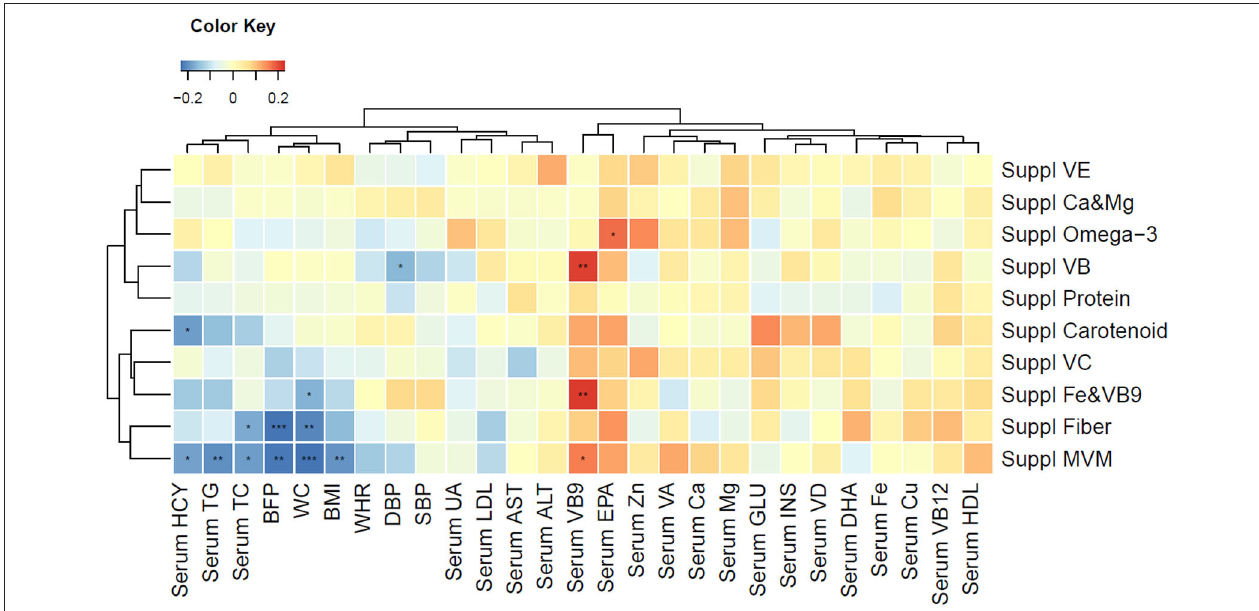
FIGURE 4 | Spearman correlation with clustered clinical outcomes (anthropometric measurements and blood biomarkers) and supplement usage. Blue color indicates strong reverse correlation; red color indicates strong positive correlation. * P < 0.05, ** P < 0.01, *** P < 0.001. ALT, alanine aminotransferase; AST, aspartate aminotransferase; BFP, body fat percentage; BMI, body mass index; Ca, calcium; Cu, copper; DBP, diastolic blood pressure; DHA, docosahexaenoic acid; EPA, eicosapentaenoic acid; Fe, iron; GLU, glucose; HCY, homocysteine; HDL, high density lipoprotein; INS, insulin; LDL, low density lipoprotein; Mg, magnesium; MVM, multiple vitamin mineral; SBP, systolic blood pressure; TC, total cholesterol; TG, triglycerides; SBP, systolic blood pressure; Suppl, supplement; UA, uric acid; VA, vitamin A; VB, vitamin B; VC, vitamin C; VD, vitamin D; VE, vitamin E; WC, waist circumference; WHR, waist-to-hip ratio; Zn,